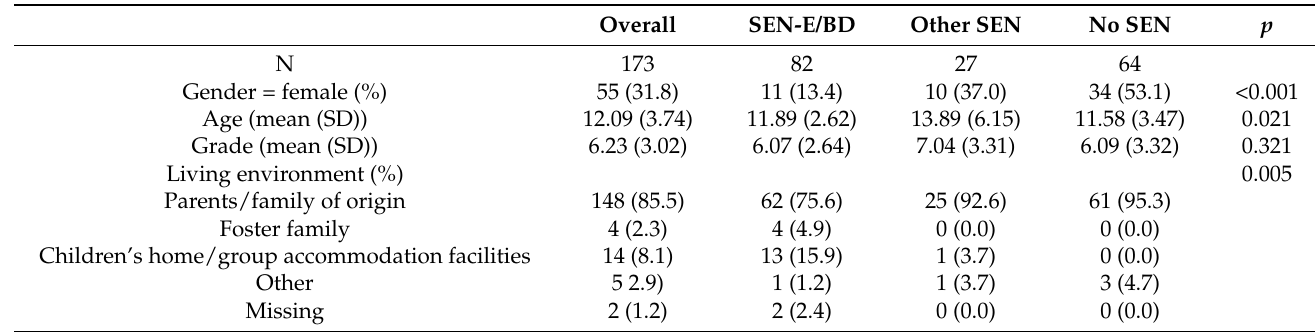
Table 2. Students’ sociodemographic